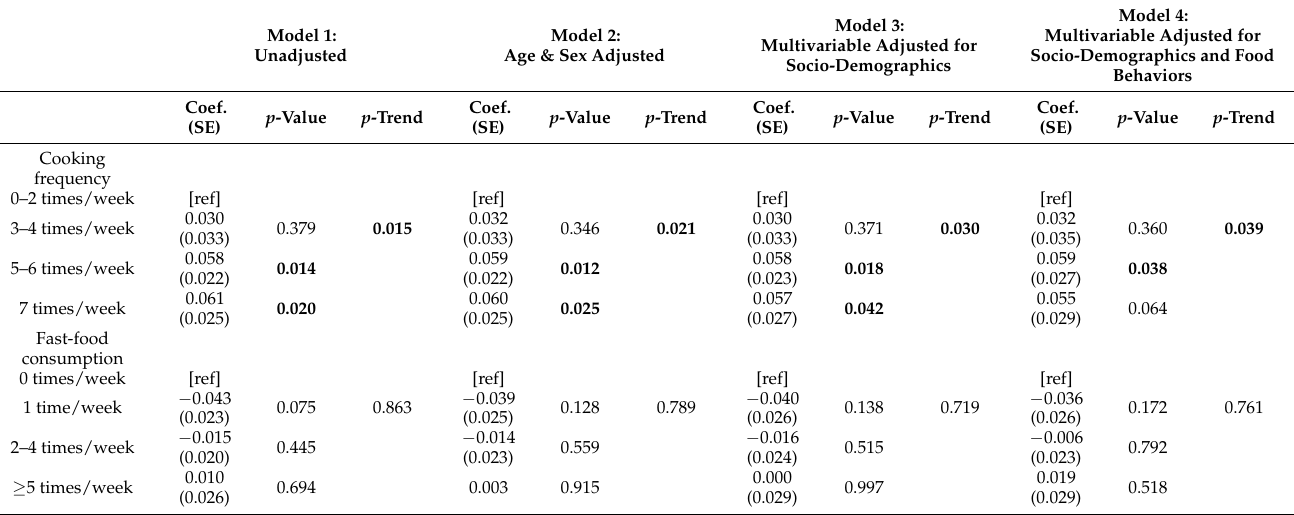
Table 2. Daily GHGE per 2000 kcal by cooking frequency and fast-food frequency, NHANES 2007–2010. Model 1: Model 2: Unadjusted Age & Sex Adjusted